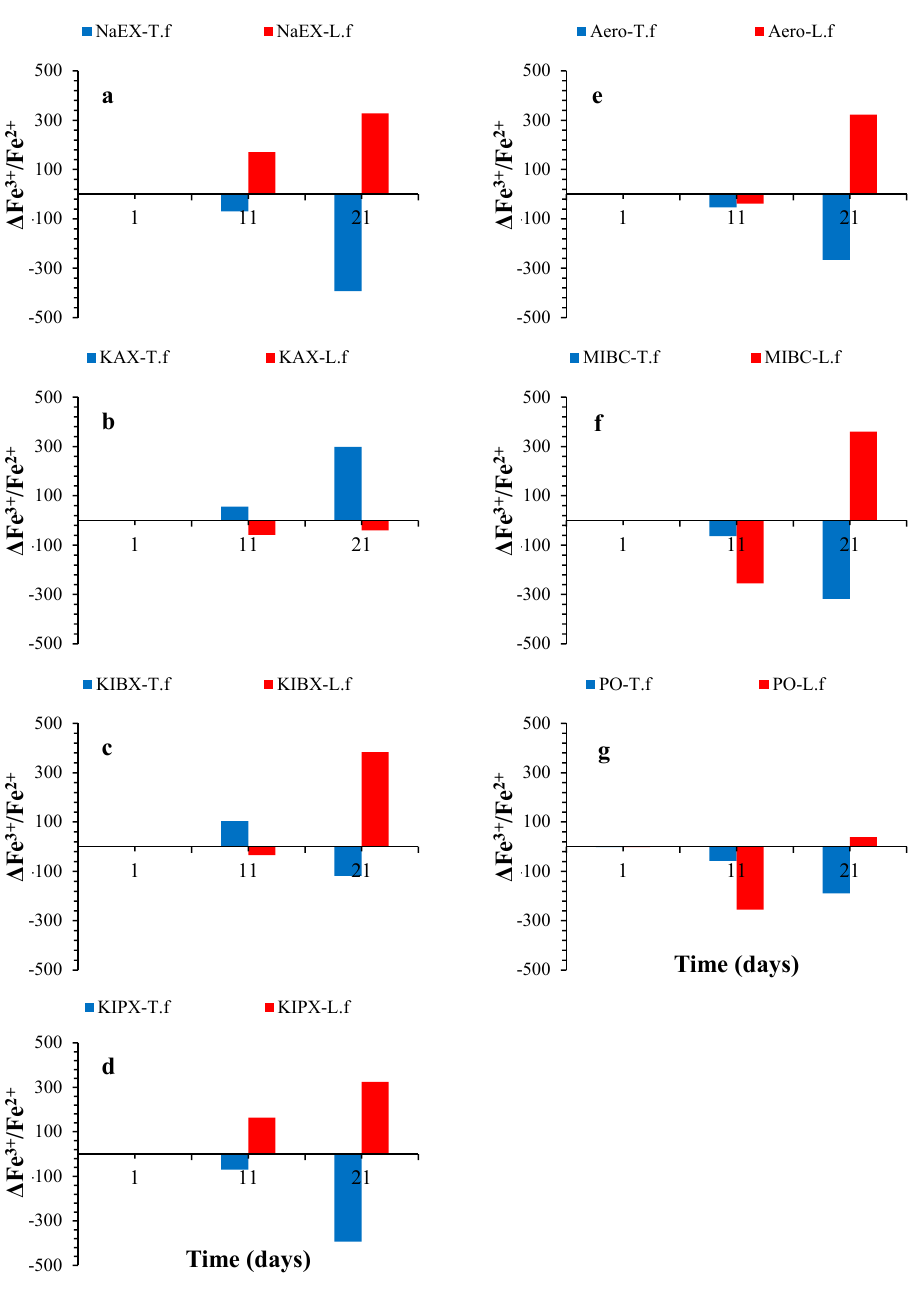
(cid:3119)(cid:3126) + ratio during L. ferrooxidans and A. ferrooxidans ratio during L. ferrooxidans (cid:2890)(cid:2915) (cid:3118)(cid:3126) Fe 2 +